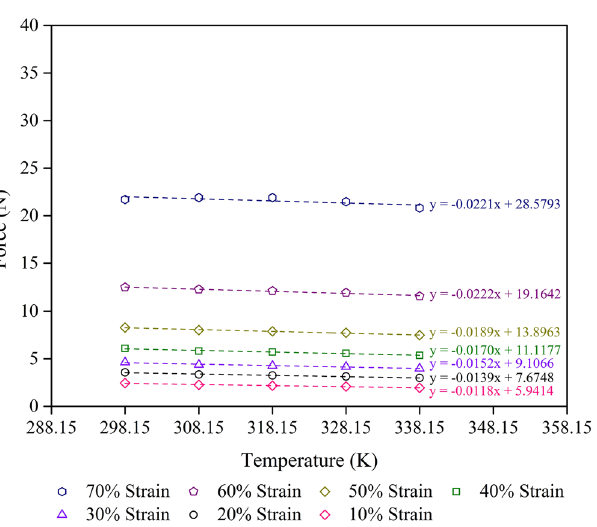
Figure 8. Force–temperature curves at given strain for the control − 10% NR sample with R 2 = 0.9 minimum at each strain. The scatter on the results is on the order of the size of the